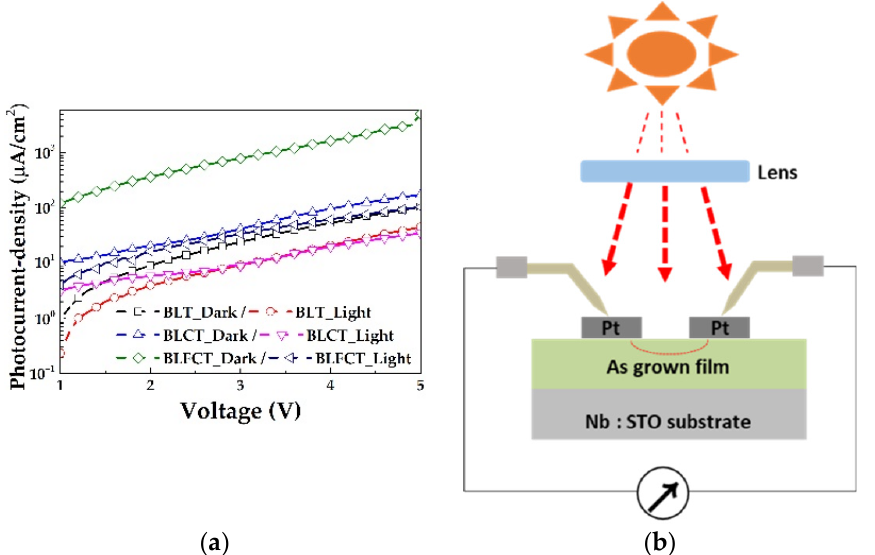
Figure 7. ( a ) Photocurrent densities of the pristine BLT and doped films on the Nb-STO substrate. ( b ) Photocurrent measurement. Pt electrodes are deposited on the films, and the current-density is measured between the two electrodes.